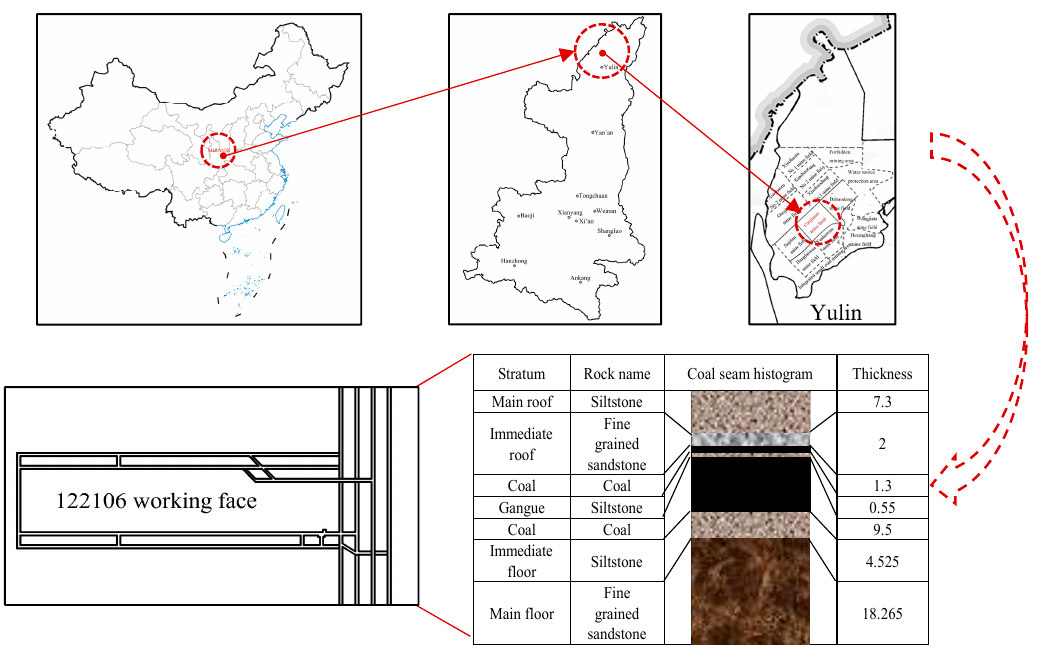
Figure 1. Project background.